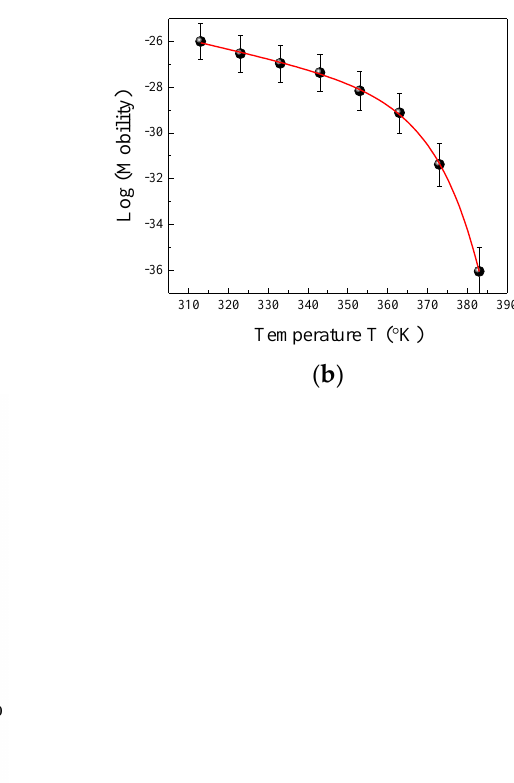
Figure 7. The log ω h versus 1000/T for PVA, PVA/LiCl film and PVA/AgNO 3 film.